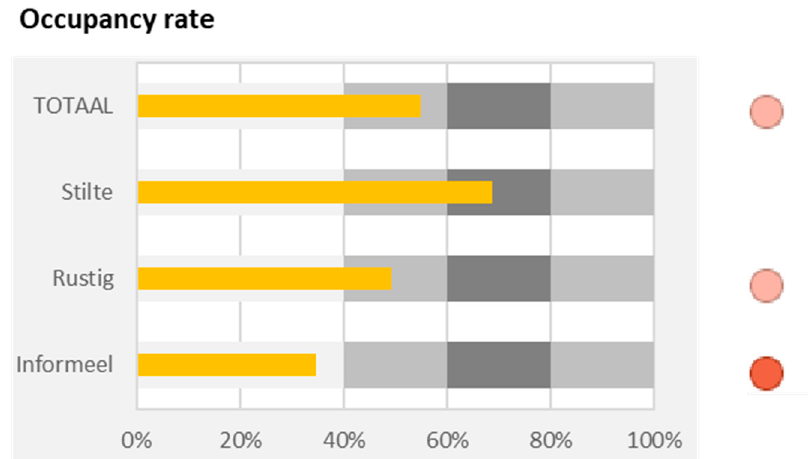
Figure 4. Example of a bullet graph (own illustration).